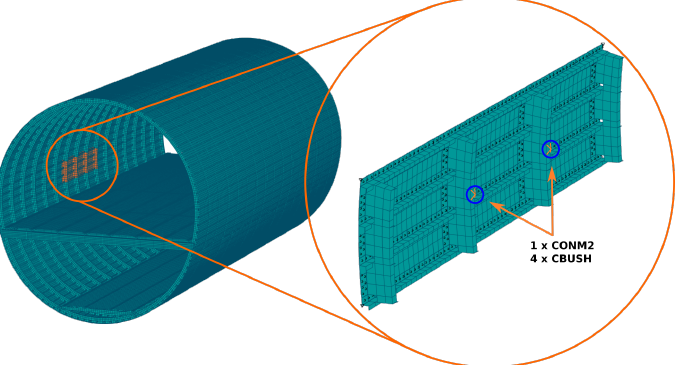
Figure 3. Acoustic Flight-LAB Demonstrator and isolated test